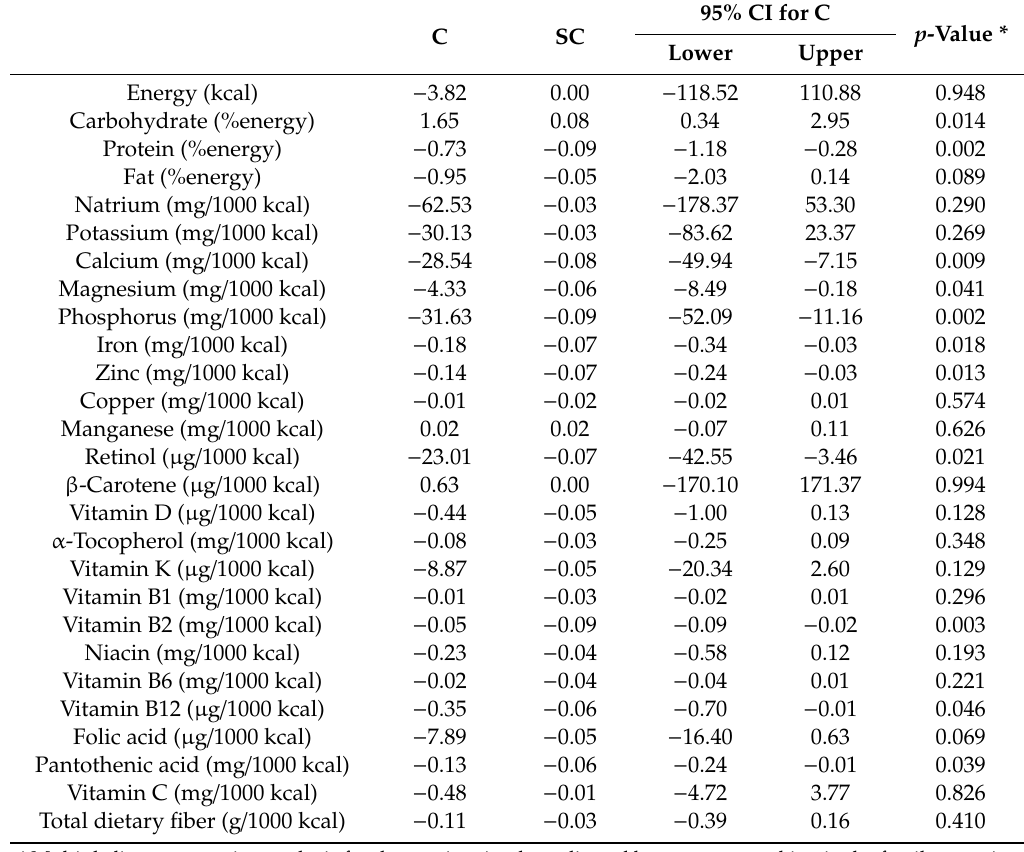
Table 4. The relationships between the ASD traits and nutrient